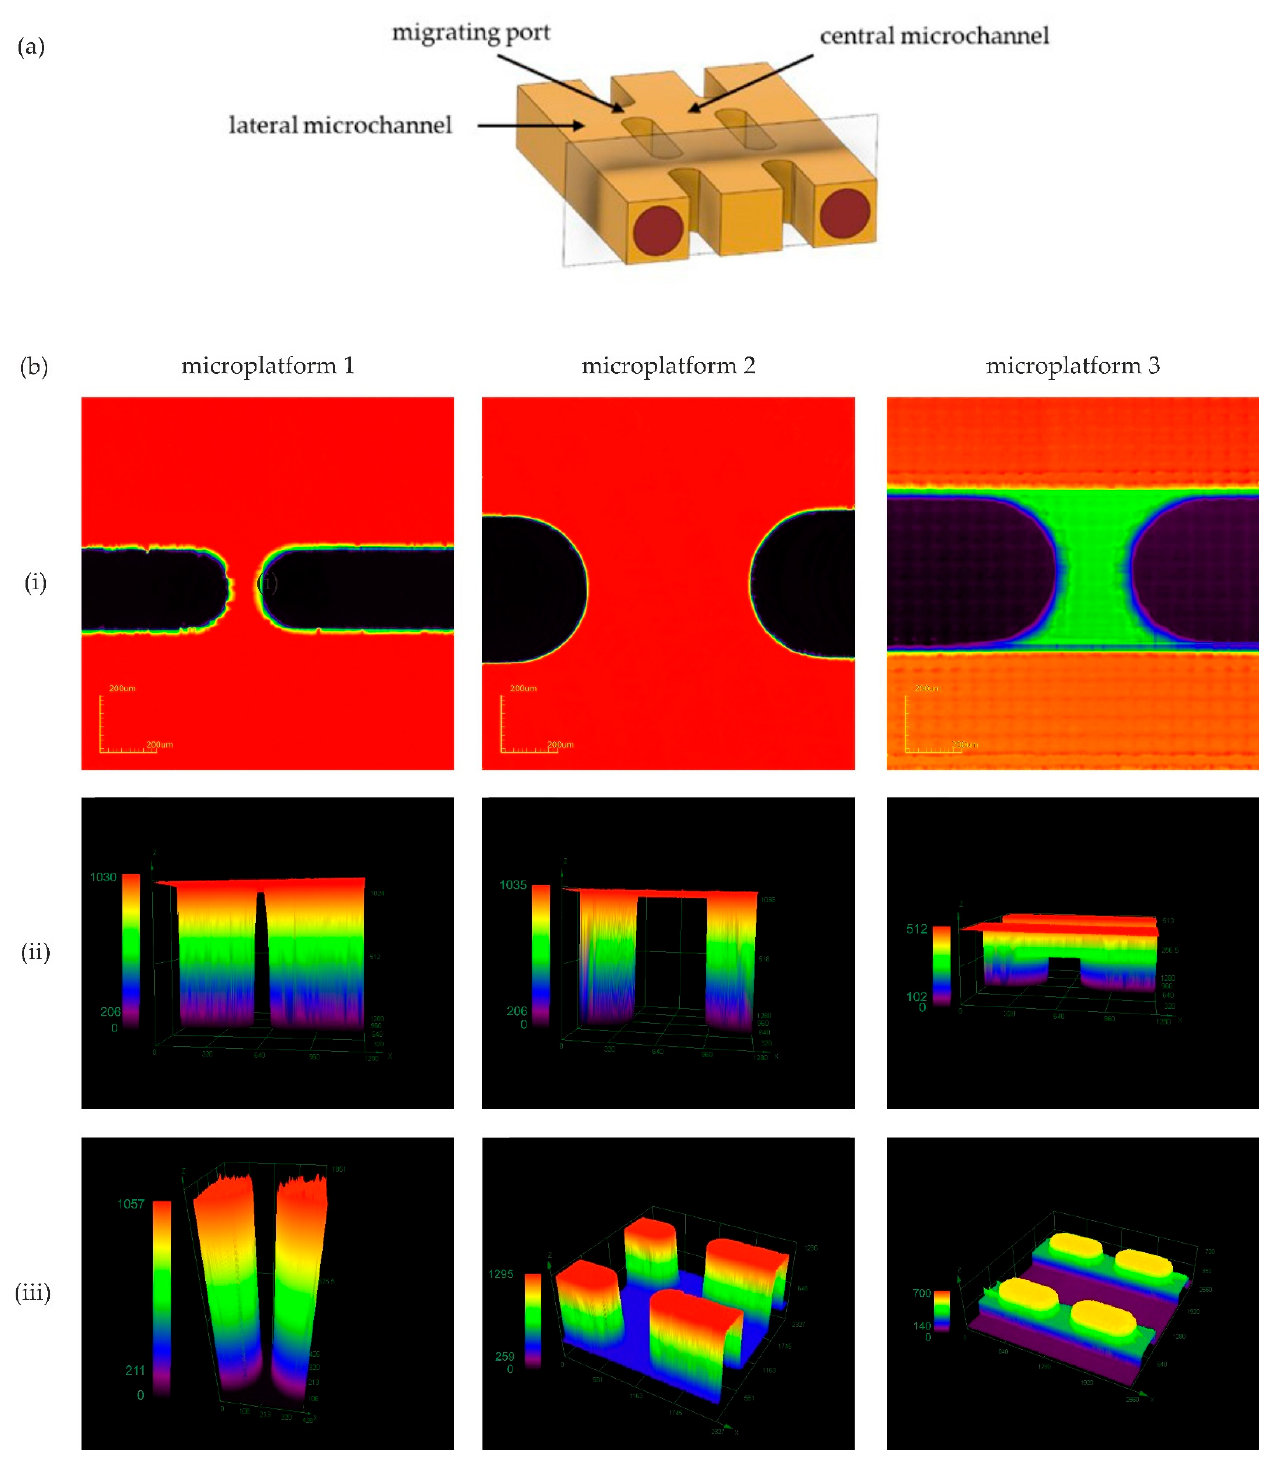
Figure 4. ( a ) Cross-sectional view of desired configuration of microchannels with marked section plane used for photos of (iii) PDMS cast. ( b ) Following images show: (i) top view of micro-milled migrating ports (PMMA mold), (ii) comparison of height of migrating ports (PMMA mold), (iii) images of migrating ports cast in PDMS. All images were captured with the use of 3D Laser Measuring Microscope (LEXT Olympus4000).